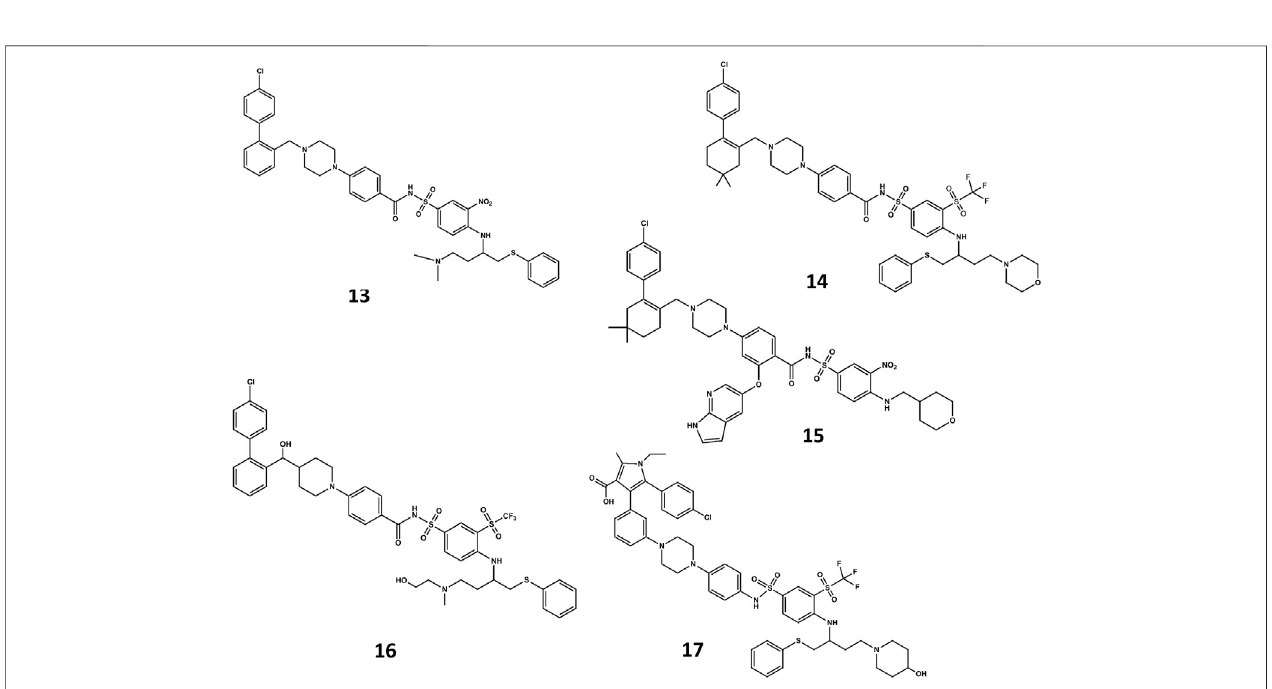
FIGURE 8 | Chemical structures of diverse small molecule mimics of the BH3 domain. ABT-737 ( 13 ); Navitoclax (ABT-263) ( 14 ); venetoclax (ABT-199) ( 15 ); BM- 975 ( 16 ); AZD4320 ( 17 ).